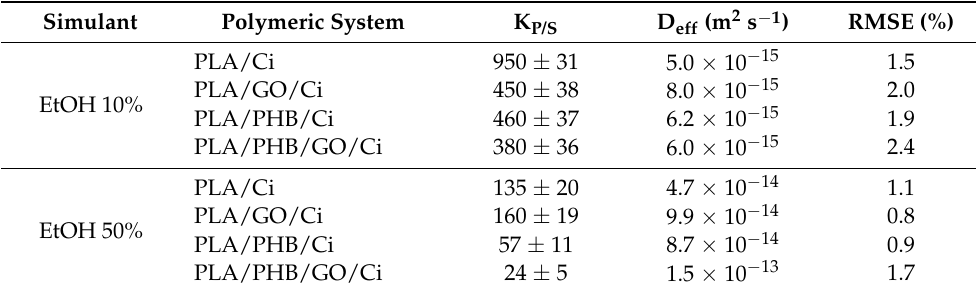
Table 2. Partition (K P/S ) and diffusion coefficients (D eff ) and RMSE values of cinnamaldehyde from PLA different polymeric systems impregnated using scCO 2